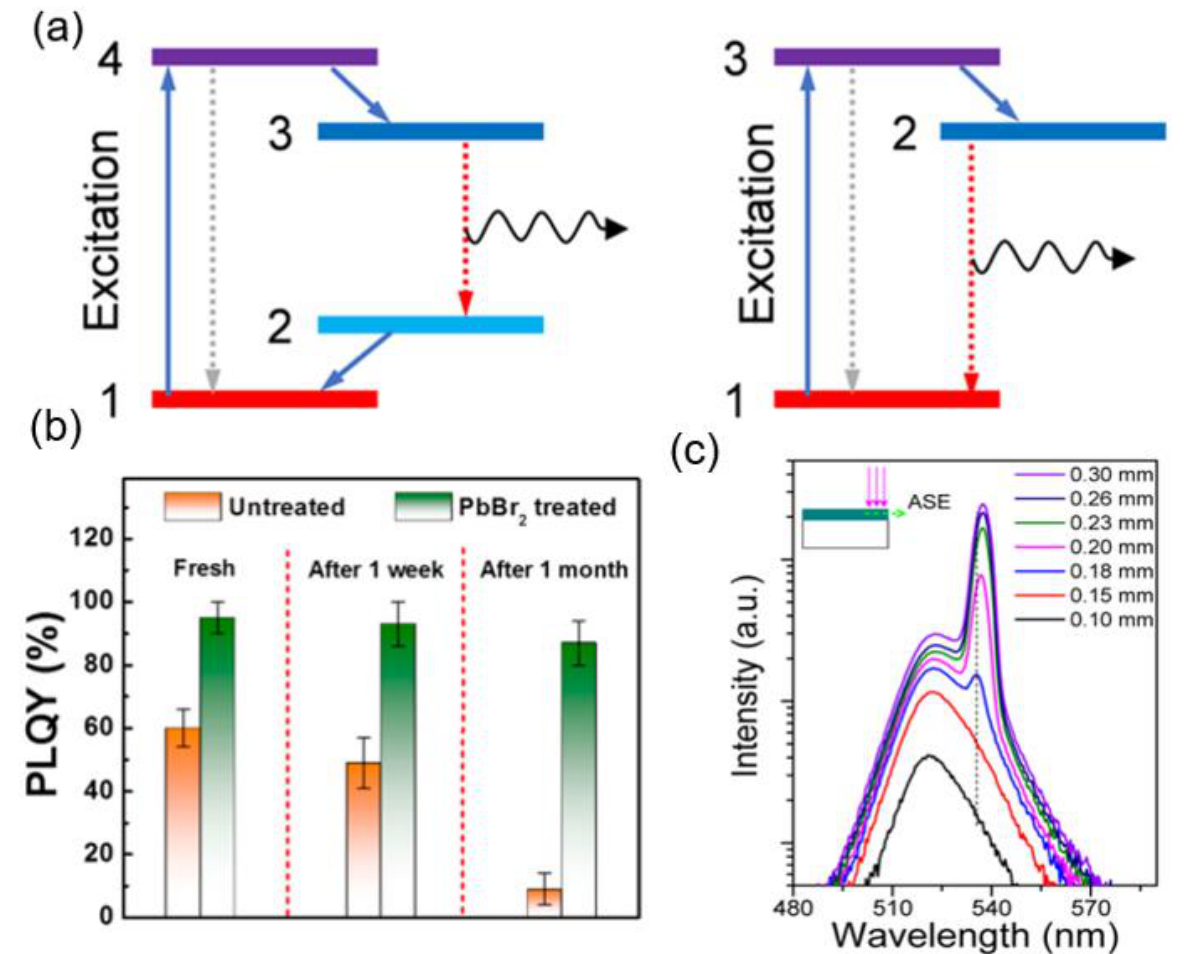
Figure 16. ( a ) Schematic of the four-level system and three-level system [86]. Copyright 2019 The Authors. InfoMat published by John Wiley & Sons Australia, Ltd. on behalf of UESTC ( b ) Experi- mentally determined PLQYs of the samples [87]. Copyright 2018, American Chemical Society ( c )